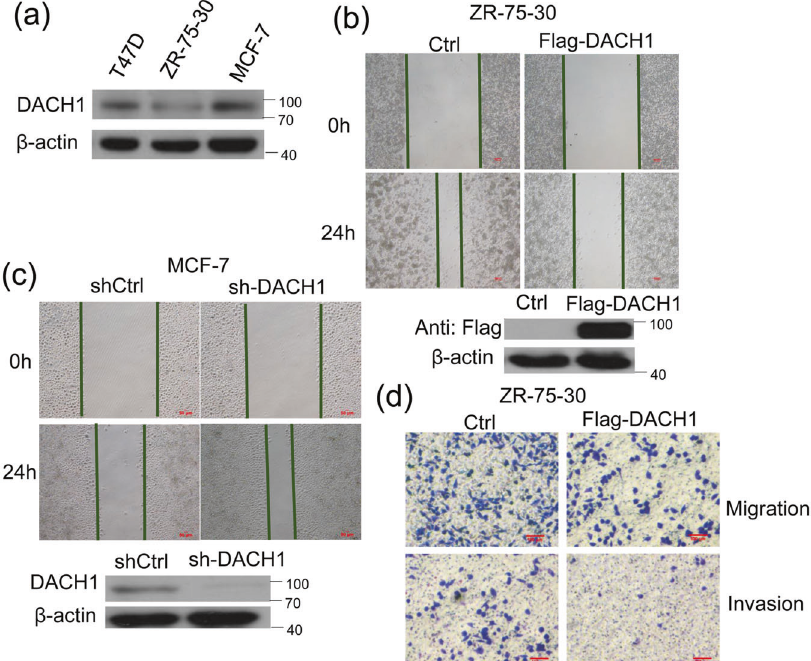
Fig. 1 The effect of DACH1 on breast cancer cell migration and invasion. a The protein abundance of DACH1 was examined by western blot in T47D, ZR-75-30, MCF-7 cell lines. b , c Scratch wound-healing assay assessing the effects of DACH1 overexpression or knockdown on the motility of ZR-75-30 and MCF-7 cells. d Transwell migration and invasion assays evaluating the effects of DACH1 on the motility and invasion of ZR-75-30 cells. Cell migration and invasion assays were performed in 24-well chambers without or with Matrigel. Cells were transfected with Flag-DACH1 or control vector and then inoculated into the upper chamber. After cultured 24 h, cells on the lower surface of the fi lter were stained and photographed. The scale bars stand for 100 μ m. Experiments were performed in triplicates and the data are representative of three independent